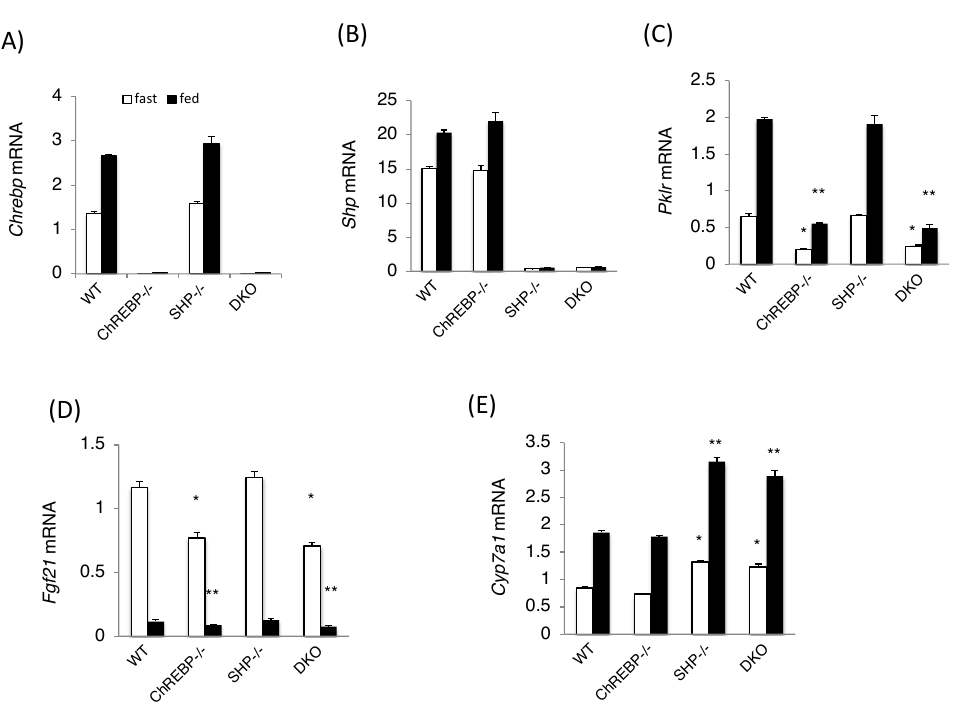
Figure 2. ChREBP and SHP target mRNA levels in wild-type, Chrebp − / − , Shp − / − , and Chrebp − / − Shp − / − mice. Carbohydrate response element binding protein (Chrebp) ( A ); small heterodimer partner (Shp) ( B ); liver type pyruvate kinase (Pklr) ( C ); fibroblast growth factor 21 (Fgf21) ( D ); and Cholesterol 7 alpha-hydroxylase (Cyp7a1); ( E ) mRNA expression analysis in the livers of wild-type, Chrebp − / − , Shp − / − , and Chrebp − / − Shp − / − (DKO) mice. Open squares indicate fasted conditions; closed squares indicate fed conditions. Pol2 expression was used as an internal control. Each mRNA levels were corrected with mouse RNA polymerase 2 mRNA. * p < 0.05 vs. WT (fast), n = 4. ** p < 0.05 vs. WT (fed), n =